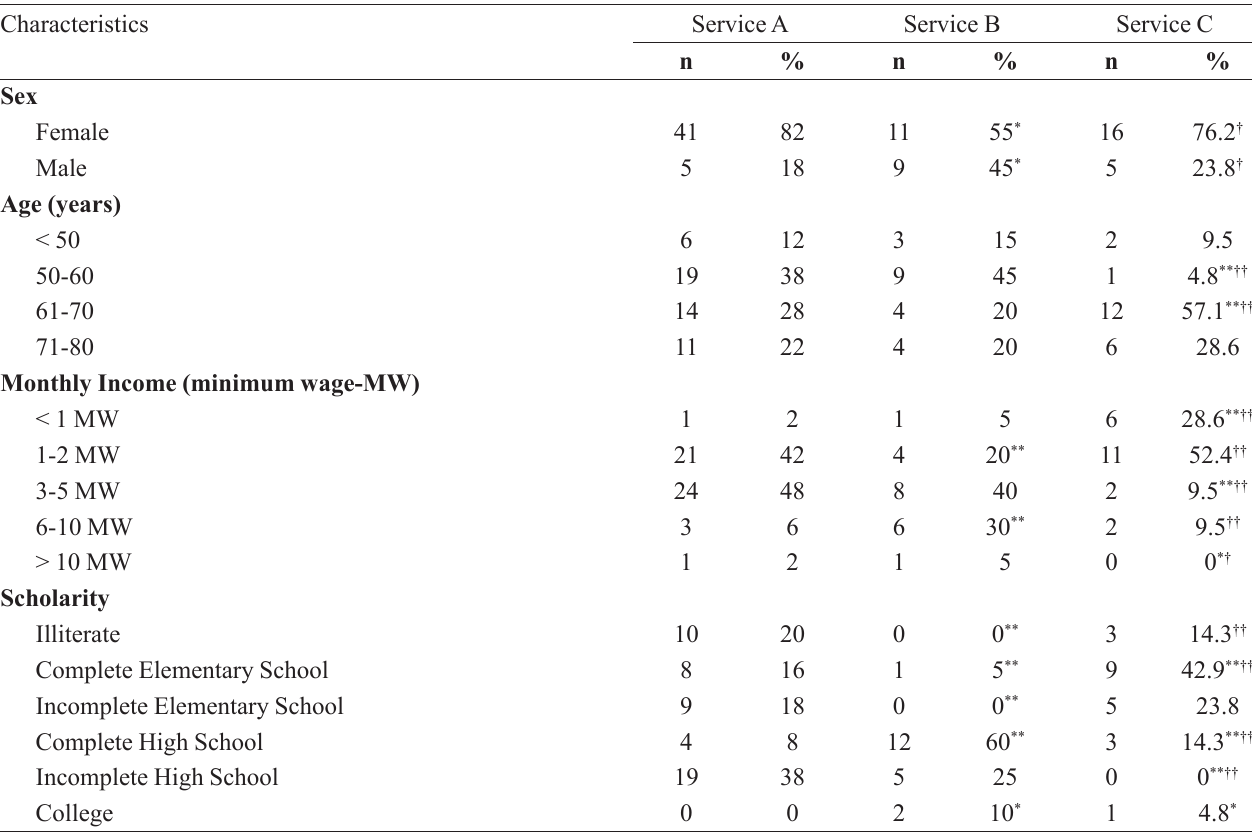
TABLE II – Distribution of absolute (n) and relative (%) frequencies, according to the socio-economic and cultural characteristics of the users